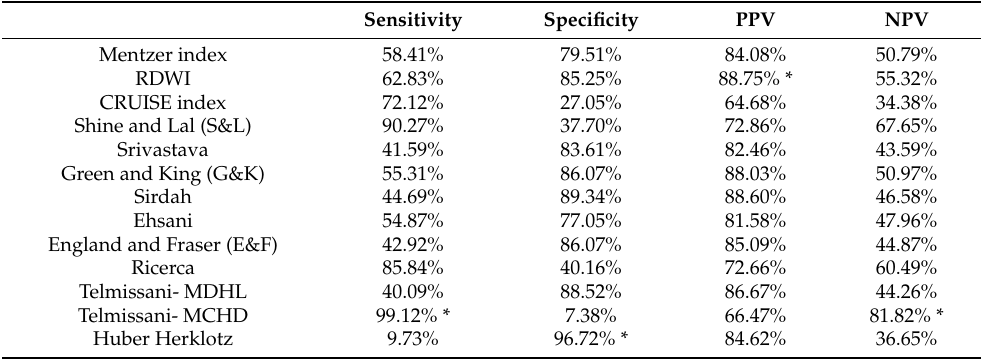
Table 2. Sensitivity, specificity, positive prediction value (PPV), and negative prediction value (NPV) of 13 indices in our study group. *, suggest that the index has the best performance in sensitivity, specificity, PPV, NPV,